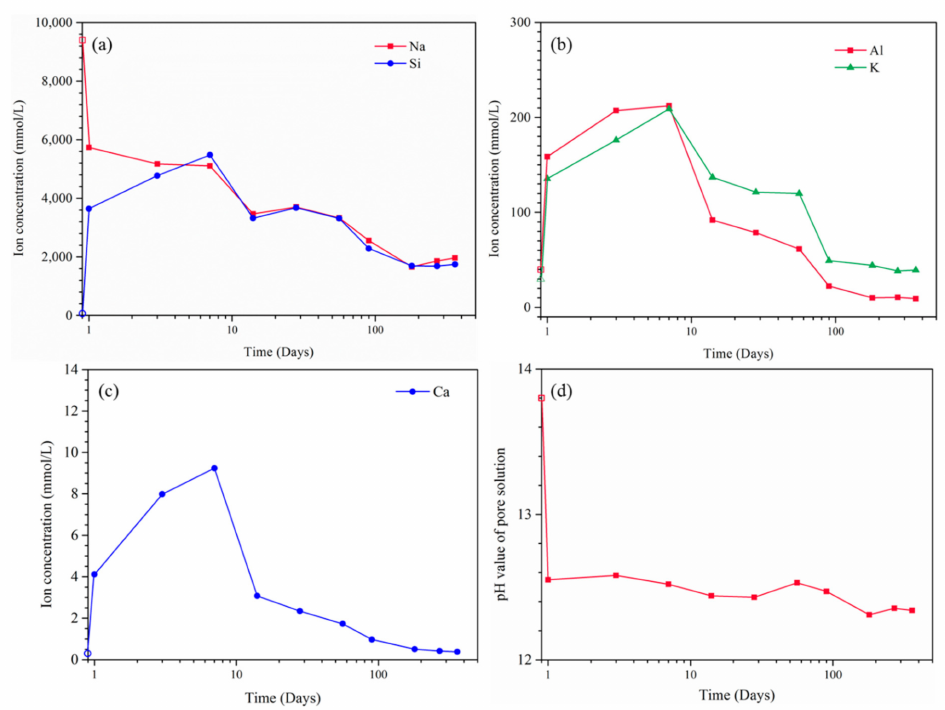
Figure 5. The concentrations of ( a ) Na, Si, ( b ) Al, K and ( c ) Ca in the pore solution as a function of time. ( d ) The pH of the pore solution as a function of time. Hollow markers are the results of the fresh paste.